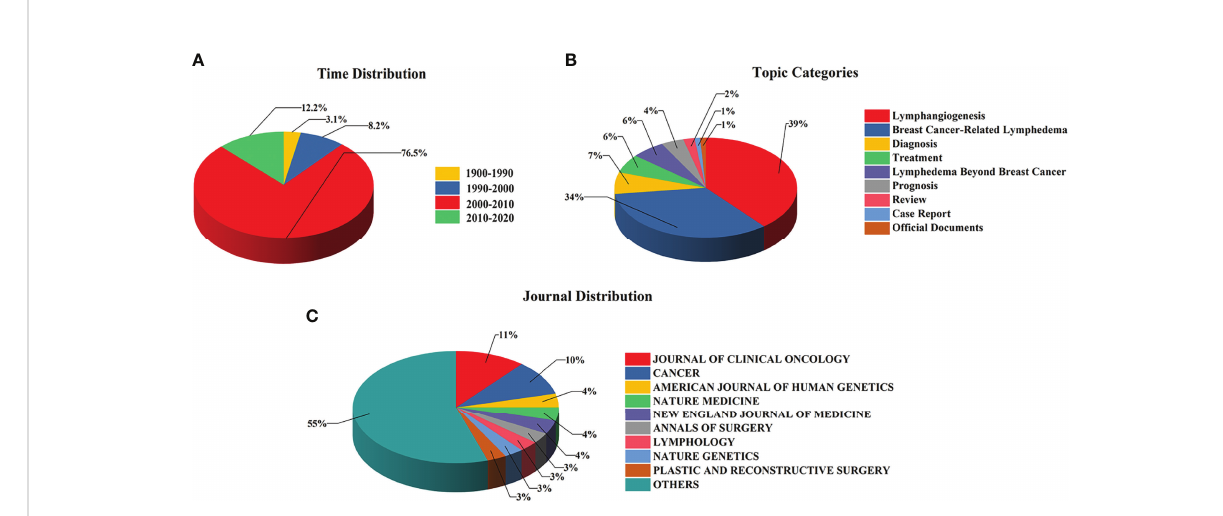
FIGURE 4 The research output characteristics of the top 100 highly cited publications. (A) The time distribution of top 100 highly cited publications. (B) The topic categories of top 100 highly cited publications. (C) The journal distribution of top 100 highly cited publications.